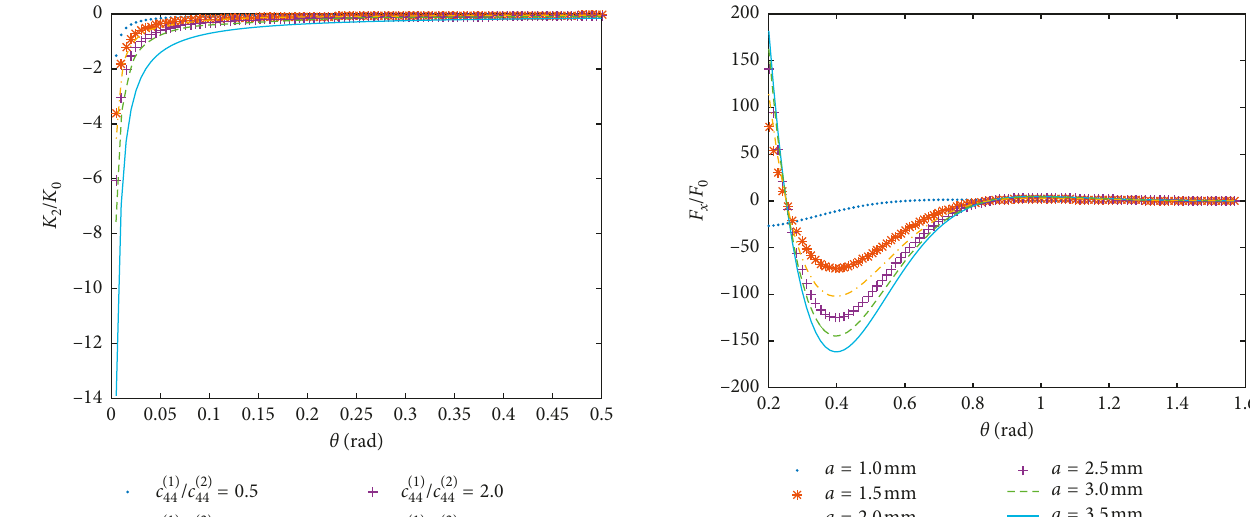
x and angle θ for